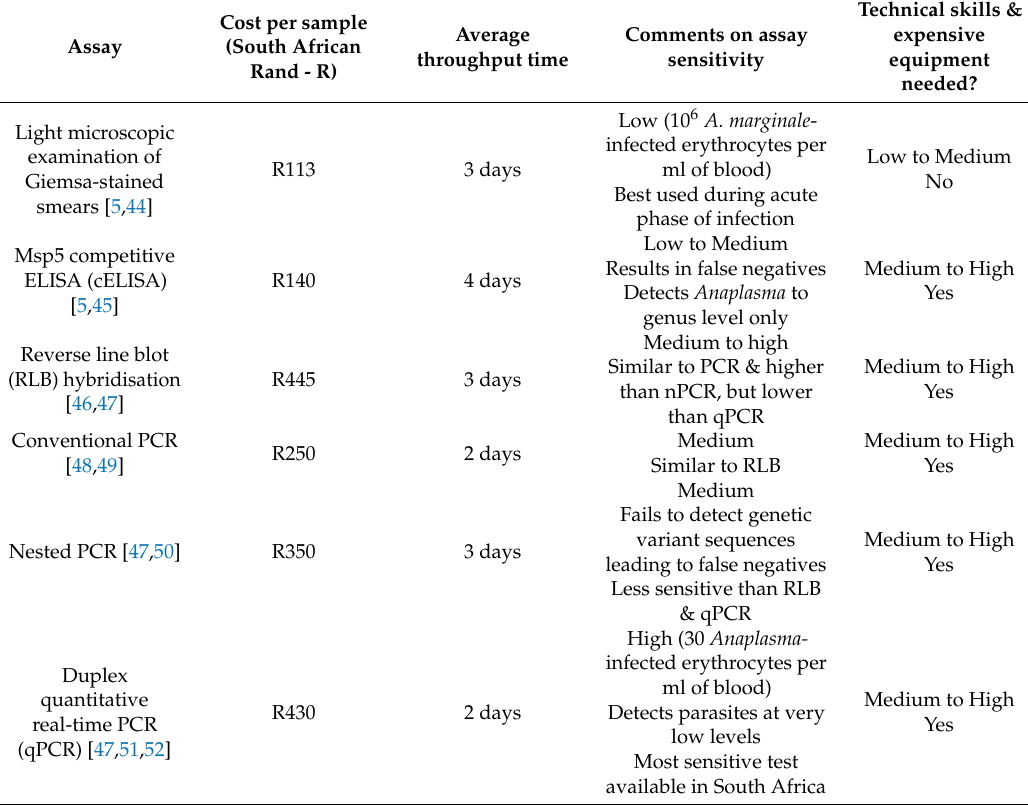
Table 1. Comparison of diagnostic assays currently in use in South Africa for detection of A. marginale and A.